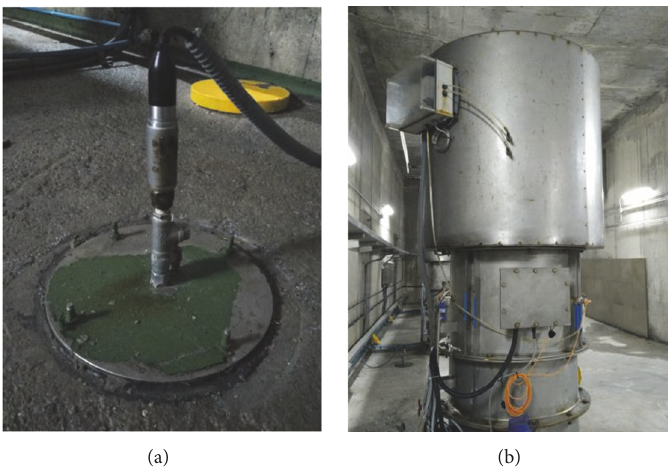
Figure 8: Pressure sensors in Mutriku. (a) Capture chamber static pressure sensor. (b) Pressure drop along the PTO sensor.